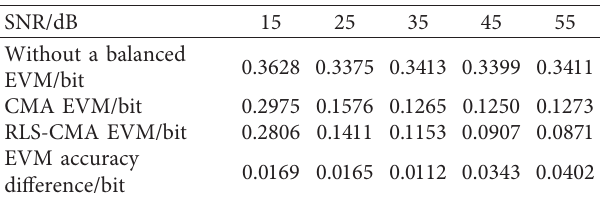
Table 3: EVM values obtained by different blind homogeneous algorithms for the 8PSK-modulated